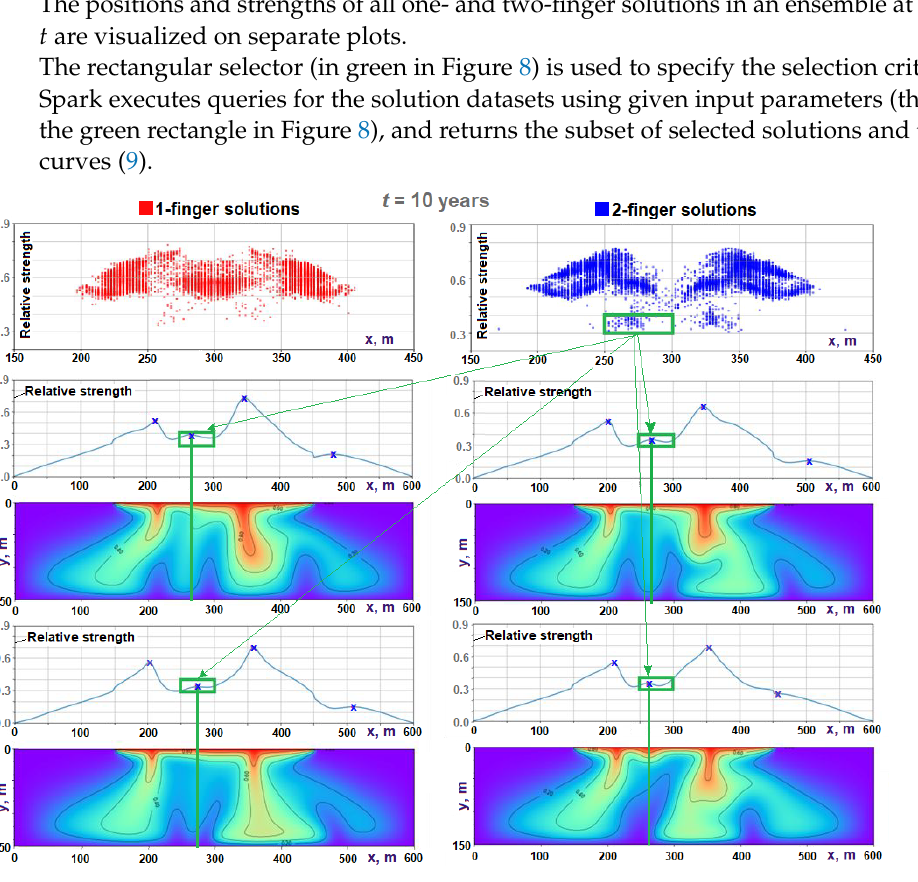
Figure 8. Visualization of the fingers of 2-finger solutions for a given subset of positions and strengths (the area inside the green rectangle). The x markers in blue indicate the peaks of the curve